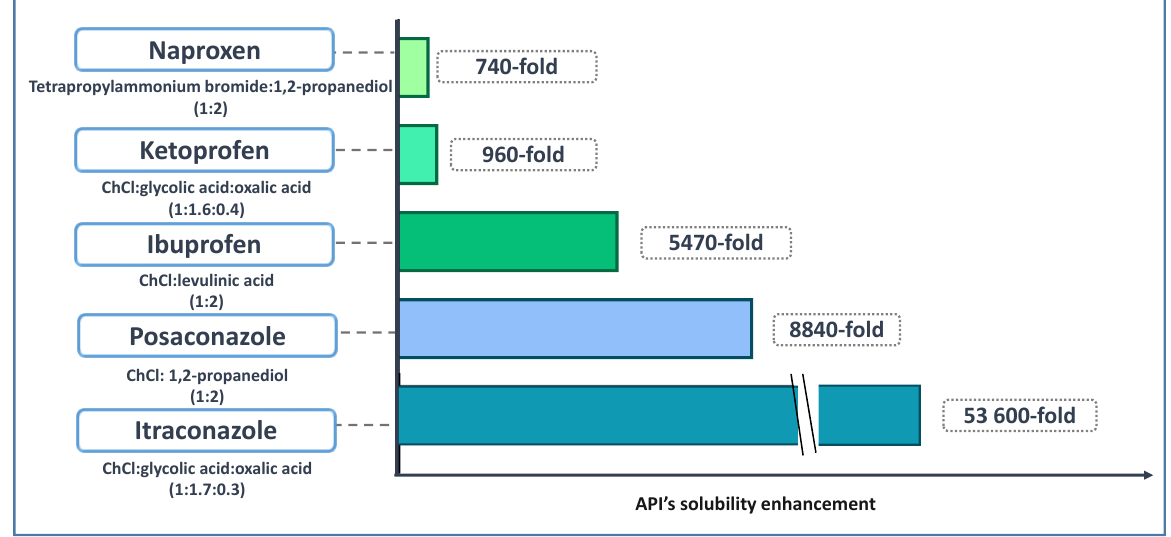
Figure 3. Examples of experimental solubility enhancements achieved for anti-inflammatory and antifungal APIs using DES as alternative solvents in comparison with their solubility in water.